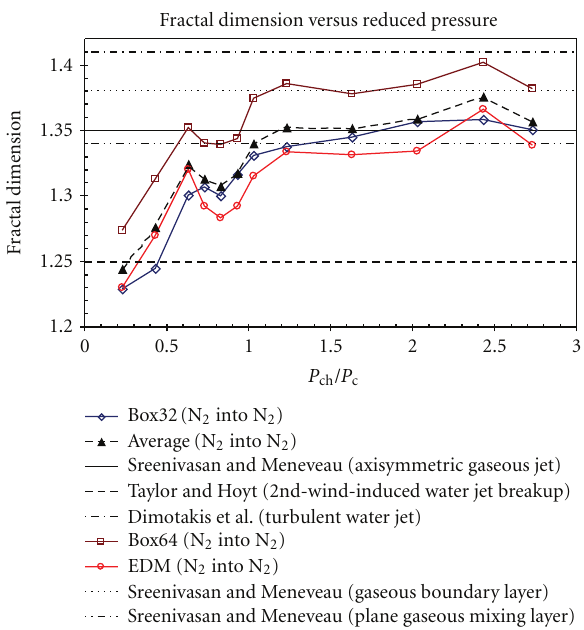
Figure 8: Fractal dimensions of the boundaries of various single jets as a function of reduced chamber pressure (chamber pressure divided by the critical pressure of the jet material). Discrete points are data from Chehroudi et al. [25, 26]. Box 32, Box 64, and EDM are di ff erent methods of calculating the fractal dimension, giving an impression of the extent of variability; for details, see Chehroudi et al. [25,